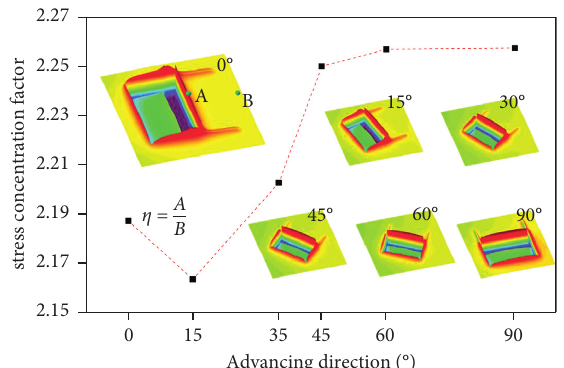
Figure 9: Maximum principal stress concentration factor of working face in different advancing